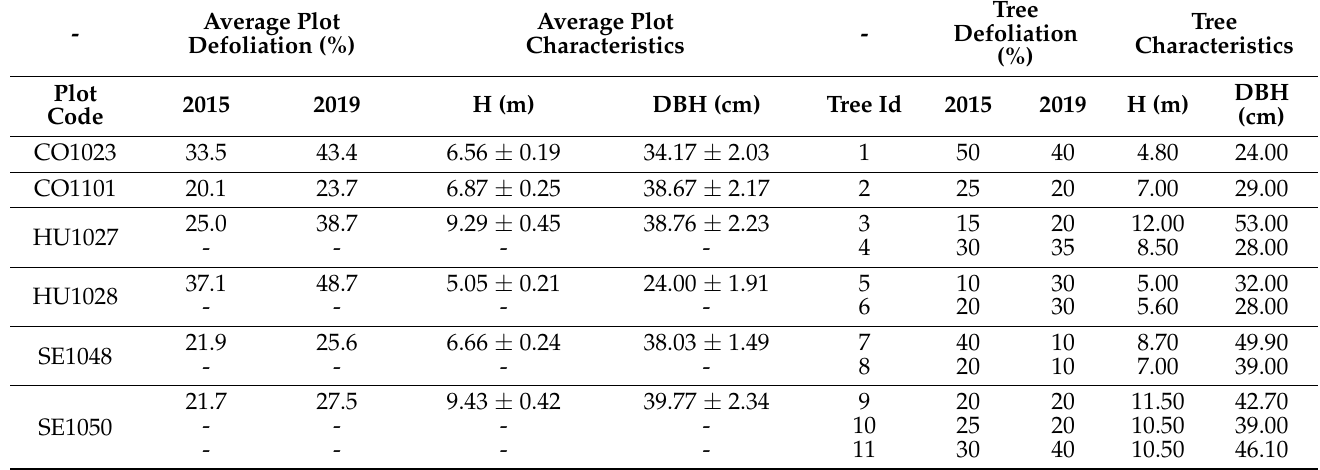
Table 1. Characteristics of the selected trees and the plots from which they belong. Defoliation values of plots (%) are expressed as the average of the crown transparency of the 24 trees belonging to each plot, and plot characteristics (height—H, and diameter at breast height—DBH) are represented as the mean value of 24 trees ± SE. All the values, including tree defoliation, and H and DBH values, were extracted from the SEDA Network database (http://www.juntadeandalucia.es/ medioambiente/site/rediam, accessed on 11 January 2021). Tree Tree Average Plot Average Plot - - Defoliation Characteristics Defoliation (%) Characteristics (%) Plot Tree Code